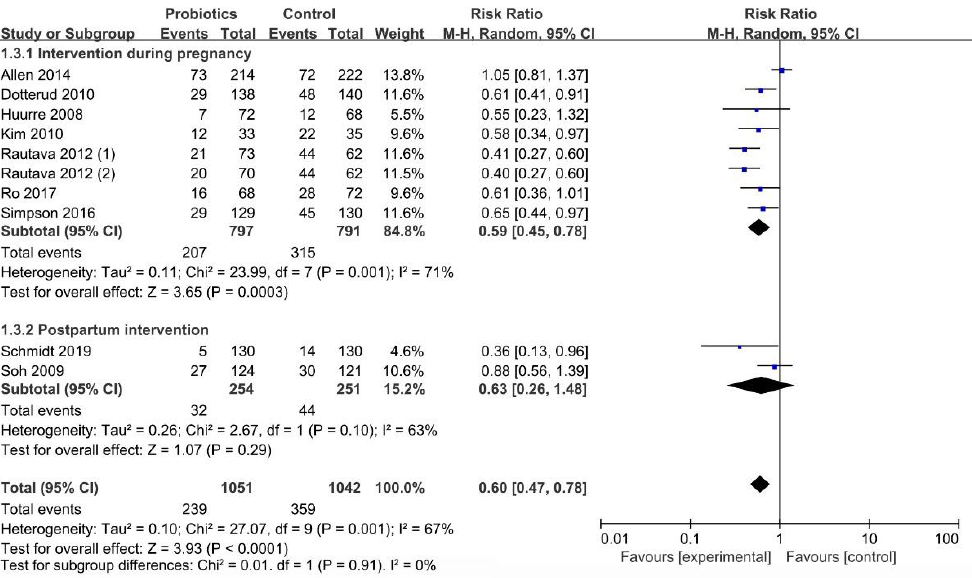
Figure 7. Intervention time subgroup analysis forest plot.